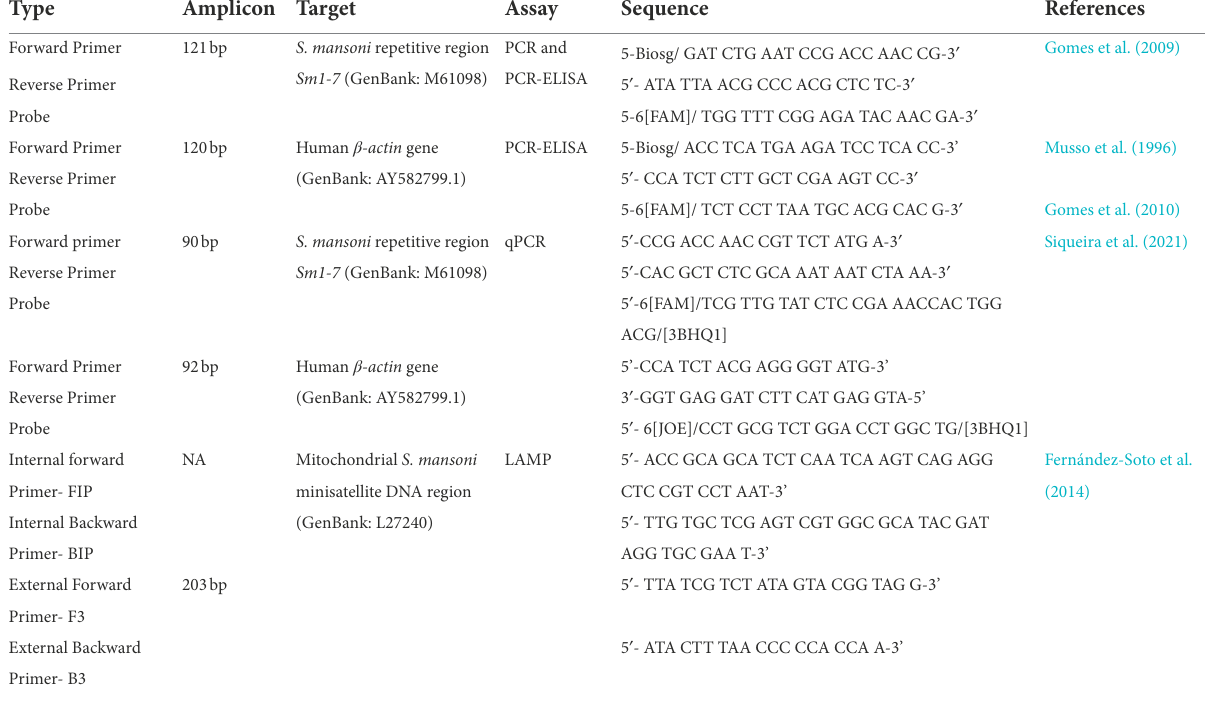
TABLE 1 Primers and probes used in the molecular